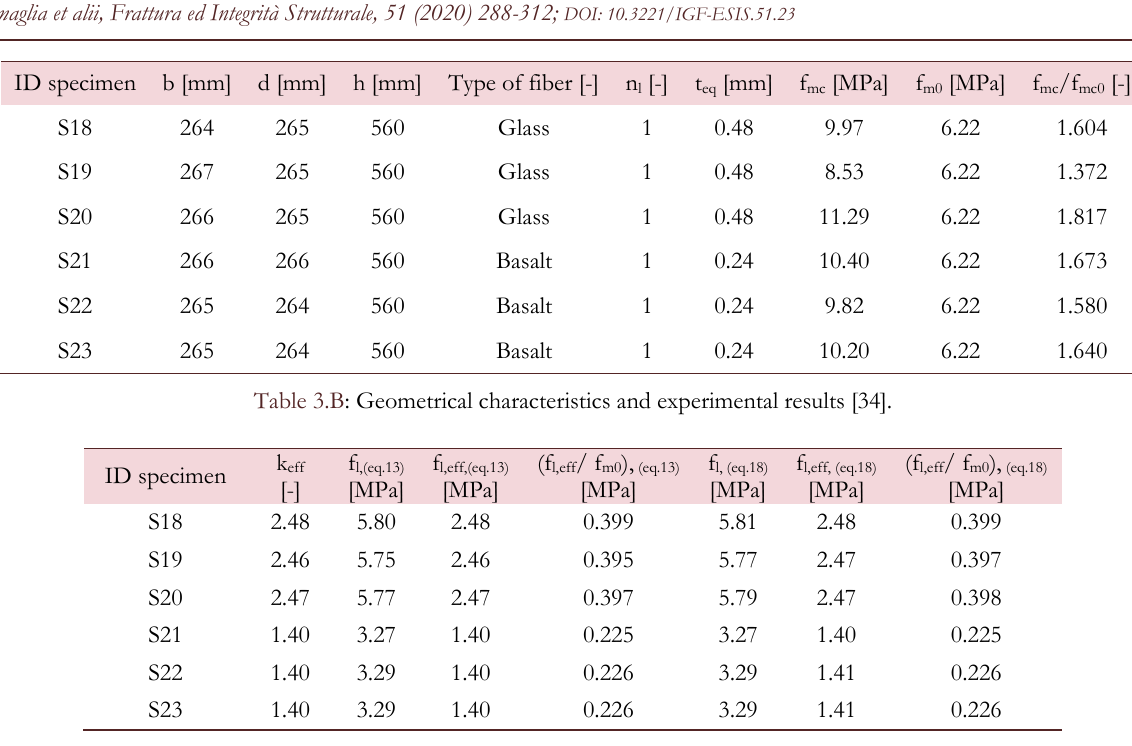
Table 4.B: Effective confining stress calculated according to Eqns. (13) and (18) for the experimental program, [34].